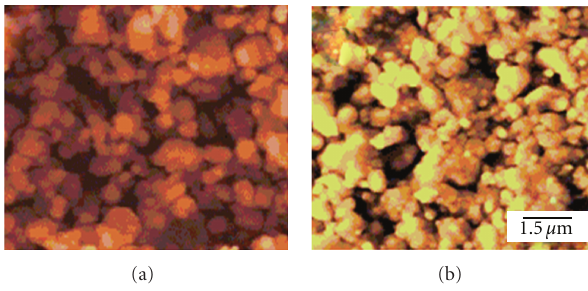
Figure 7: Scanning electron micrographs of the prepared (a) BaTiO 3 and (b) CuO.